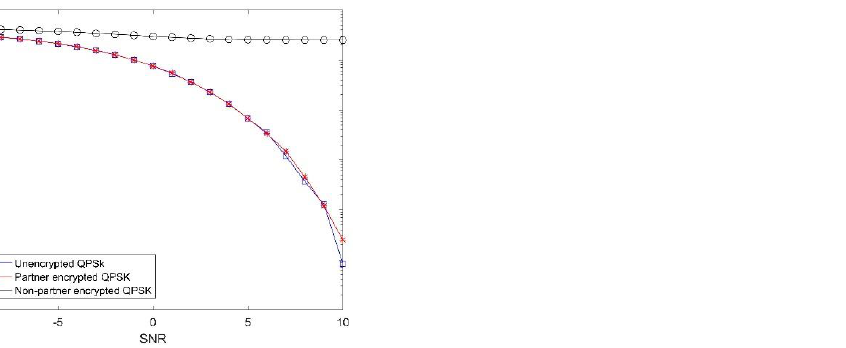
Figure 10. Simulation diagram of the bit error rate of QPSK scrambled constellation encryption al- gorithm.